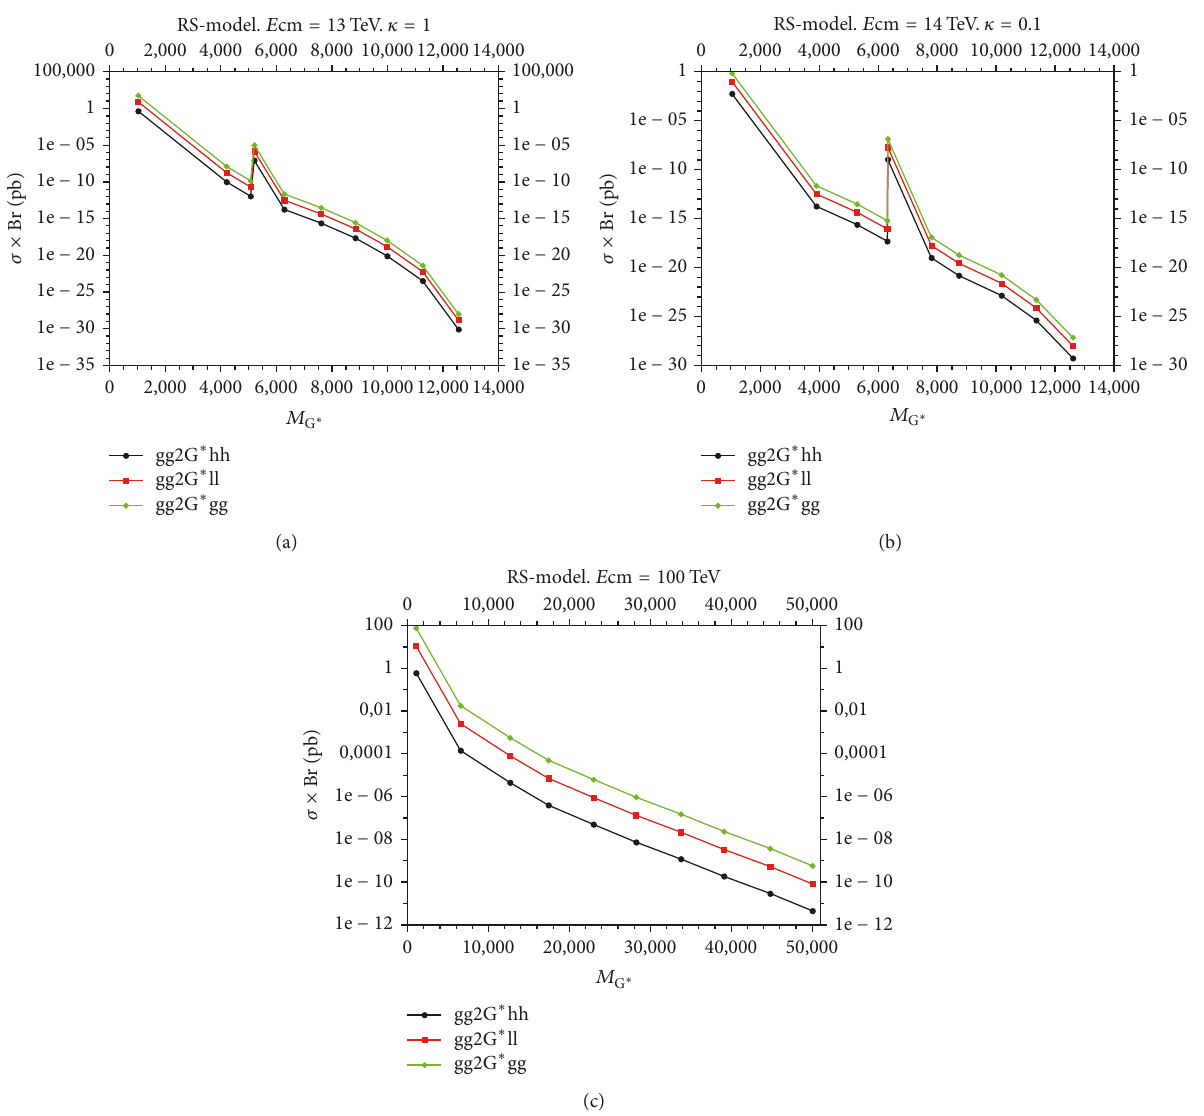
Figure 9: 𝜎 × 𝐵𝑟 for graviton production and decay as the function of graviton mass, 𝑀 𝐺 , at (a) 13TeV, 𝑘/𝑀 = 1; (b) 14TeV, 𝑘/𝑀 = 0.1; and (c) 100TeV, 𝑘/𝑀 =